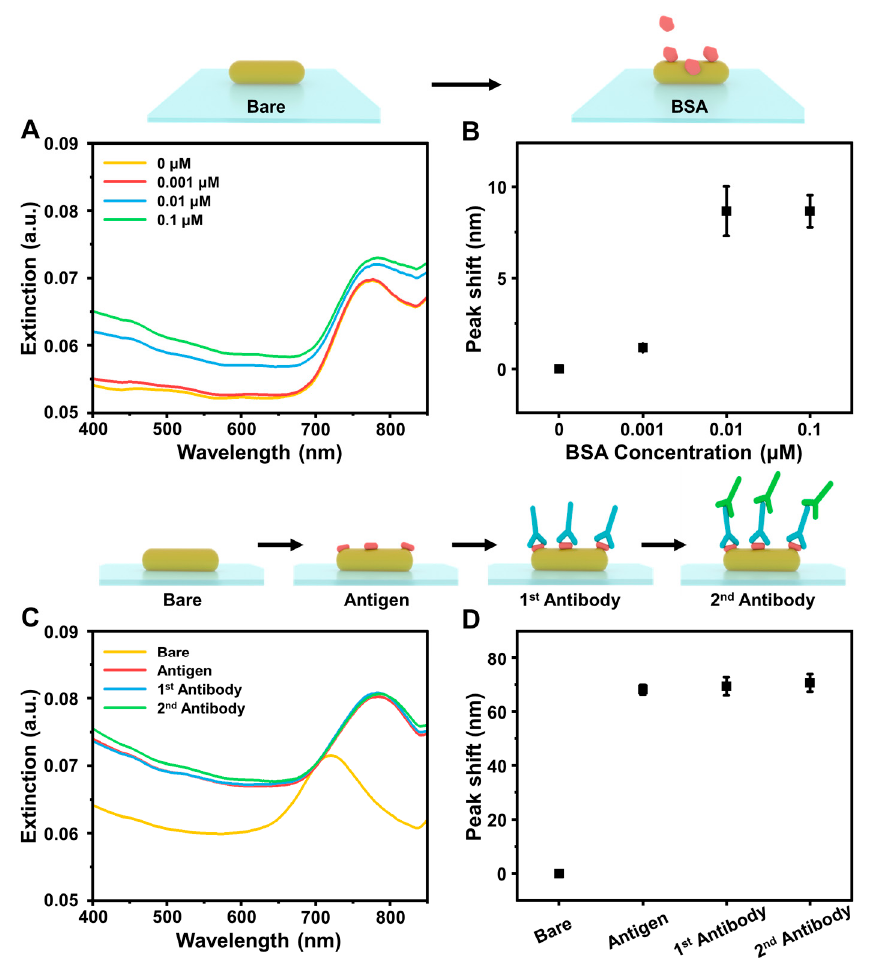
Figure 4. ( A ) Representative optical extinction spectra for BSA protein adsorption onto fabricated AuNR platform in the presence of different bulk protein concentrations. ( B ) Summary of final ∆ λ max shifts corresponding to data in panel ( A ). ( C ) Representative optical extinction spectra for sequential addition of COVID-19 N antigen, primary antibody, and secondary antibody onto fabricated AuNR platform. ( D ) Summary of final Δ λ max shifts corresponding to data in panel ( C ). Data in panels ( B ) and ( D ) are reported as the mean ± standard deviation from three experiments.